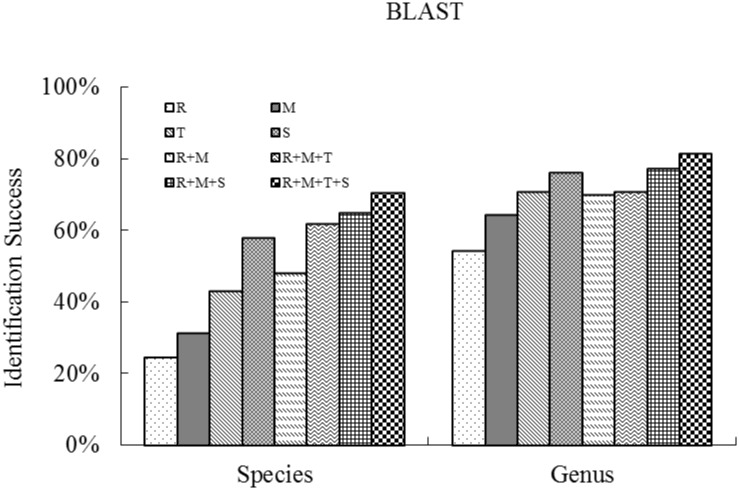
Percent species resolution at the genus and species levels for single regions and combinations, based on BLAST analysis of all the samples, collected from the four plots (BB, JJYL, GGYL and LSL) of Xishuangbanna Nature Reserve in southwest China.(R, M, T, S represent rbcL, matK, trnH–psbA and ITS respectively.)